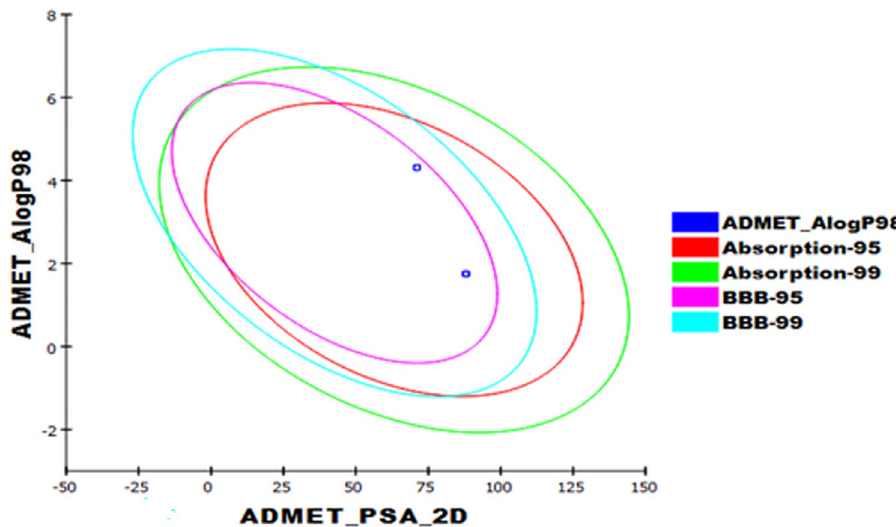
Fig 16. Computational prediction of ADMET parameters for T-1-MTA and